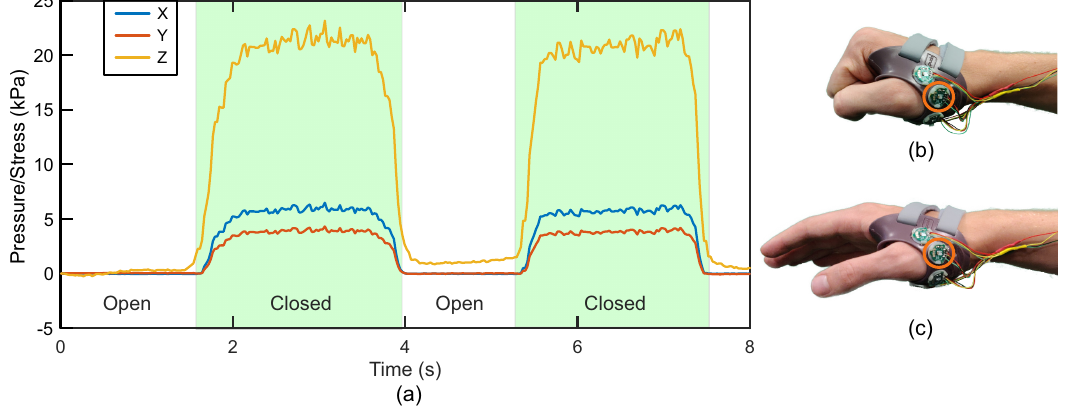
Figure 9. ( a ) Response of the prototype from a single sensor on the sensorised splint over two hand closing actions (closed hand indicated in green), ( b ) closed hand, and ( c ) open hand. The orange circle indicates the sensor from which the measurements were